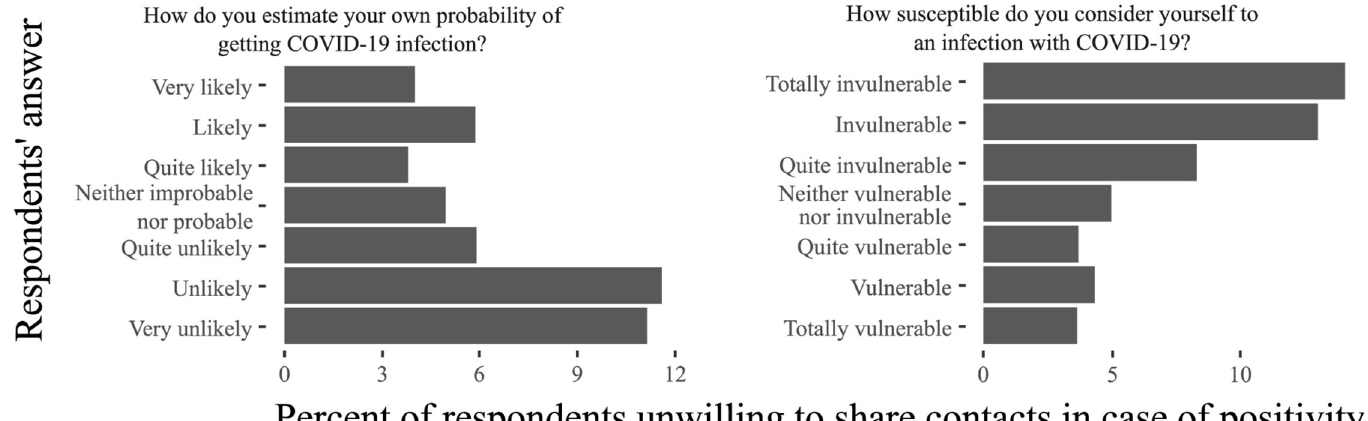
Fig 1. Percent of respondents who expressed unwillingness to share contacts in case of positivity, according to their response to the questions about personal probability of being infected.